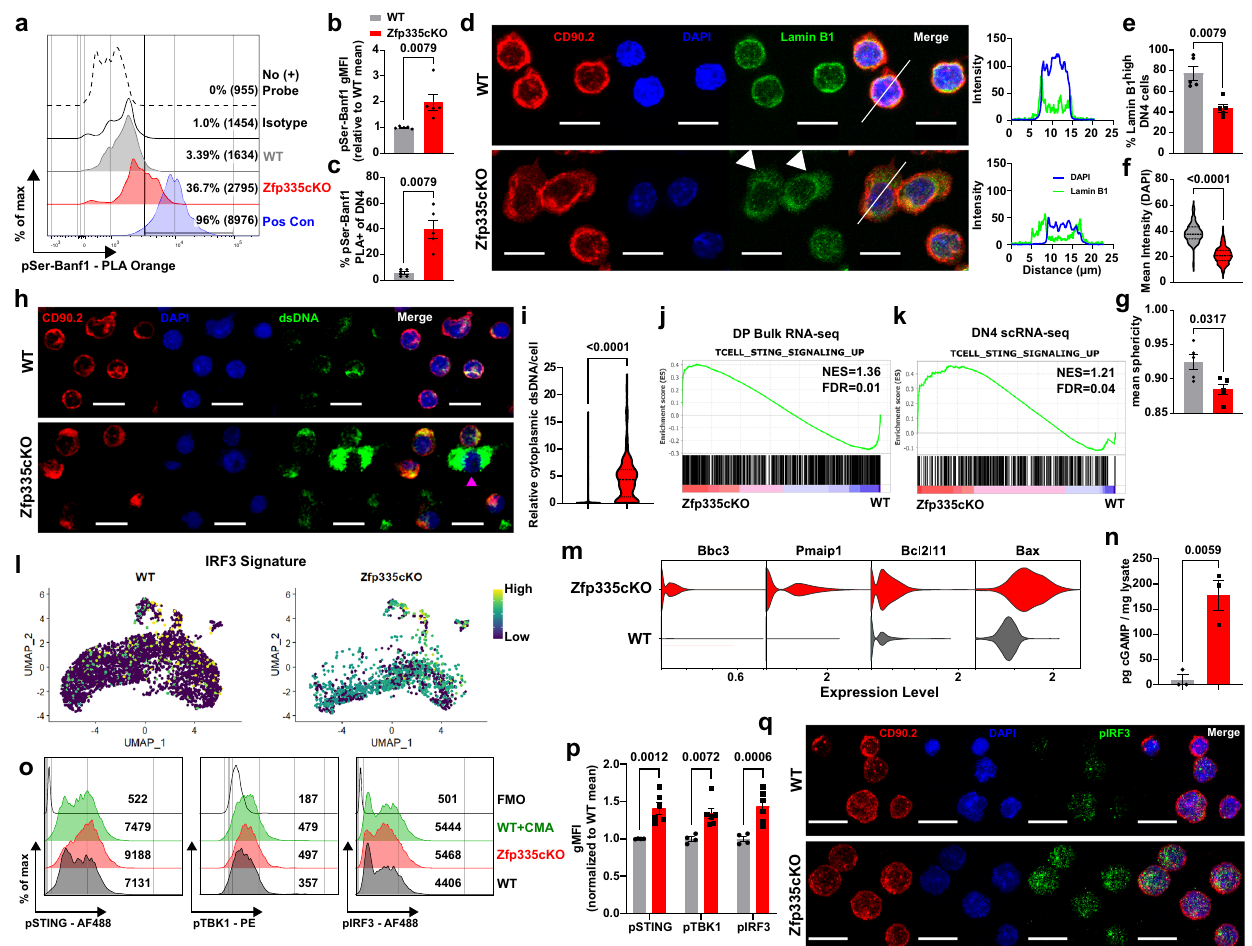
Fig. 6 | Loss of Zfp335 leads to altered nuclear envelope architecture, accu- mulation of cytosolic dsDNA and promotes cGAS/STING signaling. a Representative histograms and gating of Baf phosphorylation as measured by proximity ligation assay (PLA). Percent phosphoserine-Baf and geometric MFI in parenthises are shown. Phosphoserine-Lamin B1 PLA was used as positive control. Quanti fi cation of Baf phosphorylation based on geometric MFI ( b ) or percent positive cells ( c ). n =5 mice per genotype. d Representative immuno fl uorescence images of full cell thickness maximum intensity projections (left) and pro fi le plots (right) of nuclear envelope staining in ex vivo DN4 thymocytes. Pro fi le plots are based on white lines shown in merged images. Scale bars represent 10 µ m. Quan- ti fi cationoffrequencyofcellswithhighnuclear-associatedLaminB1( e ),meanDAPI pixel intensity ( f ) or mean nucleus sphericity ( g ) for ex vivo DN4 thymocytes. e , g n =5 mice per genotype, f n =124 WT and n =490 Zfp335cKO cells. Repre- sentative images ( h ) and quanti fi cation ( i ) of cytoplasmic dsDNA in WT ( n =548 cells, 4 mice) or Zfp335cKO ( n =268 cells, 6 mice) thymocytes following 3 days in